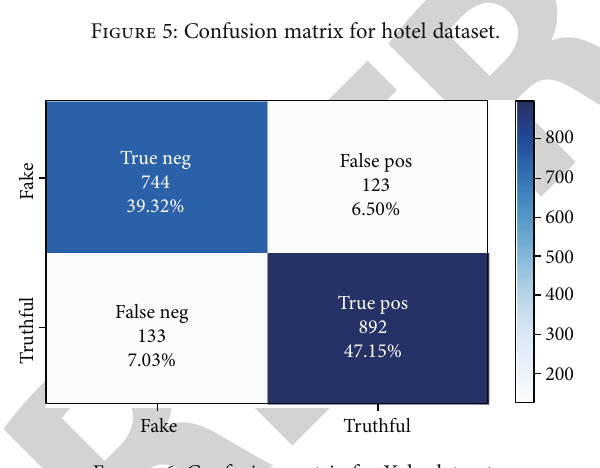
Figure 5: Confusion matrix for hotel dataset.